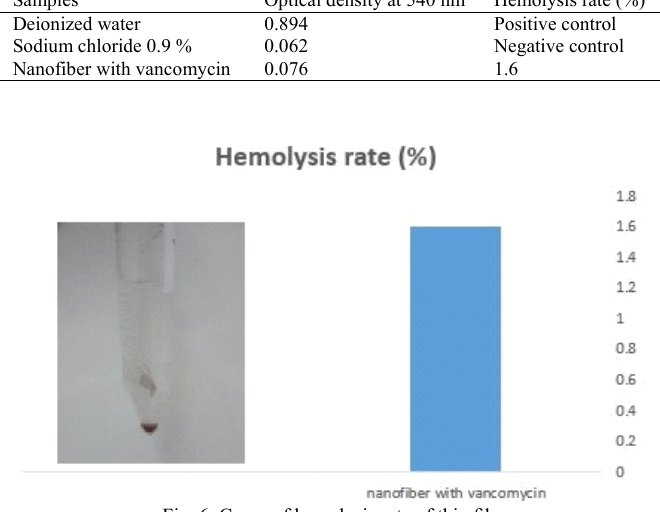
Fig. 6. Curve of hemolysis rate of thin film